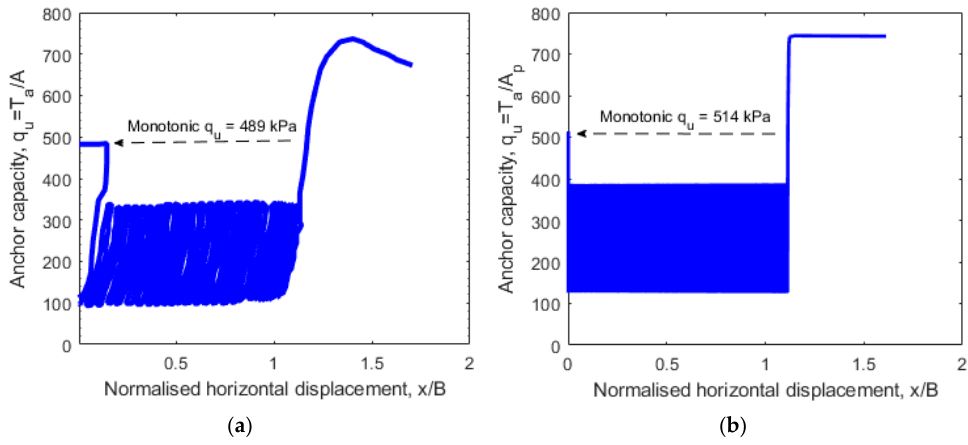
Figure 9. Comparison between experimental and simulated anchor capacities: ( a ) centrifuge test [25]; ( b ) macro-element model result.